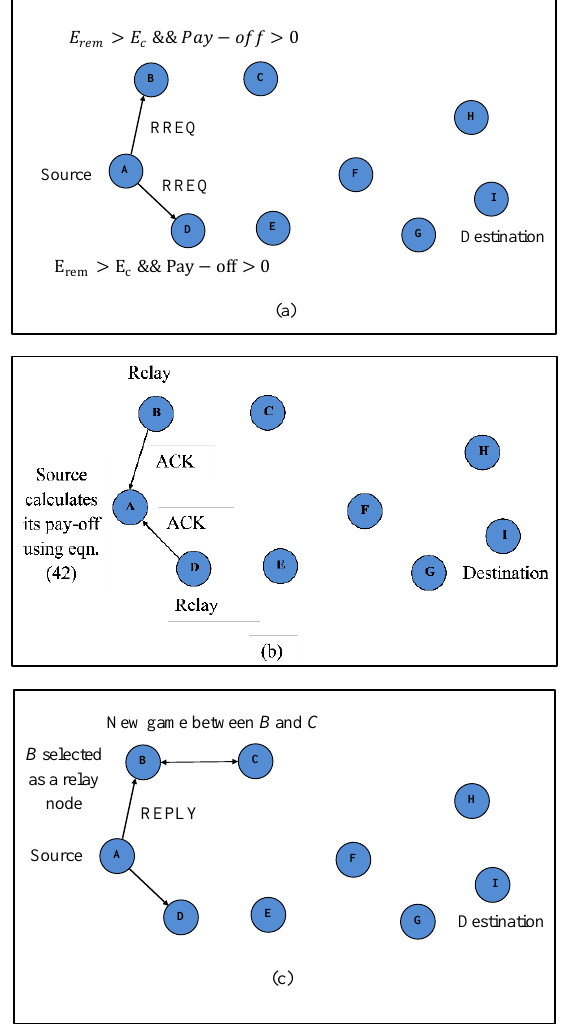
Figure 8. Network scenarios where the neighboring node does not know the optimal route to the destination: ( a ) the source nodes send route request message to neighbor nodes and the neighboring nodes decide if they can be a relay, ( b ) the source node receives acknowledgements (ACKs) from the relays and calculates its own pay-off, and ( c ) the source node chooses its new relay game between B and C